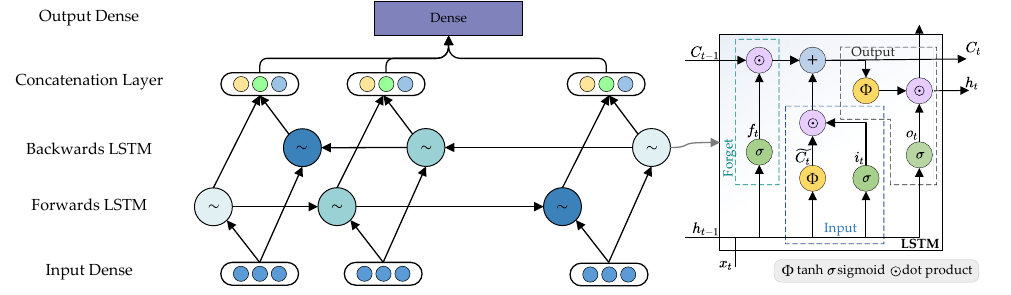
Figure 2. BiLSTM module for natural gas